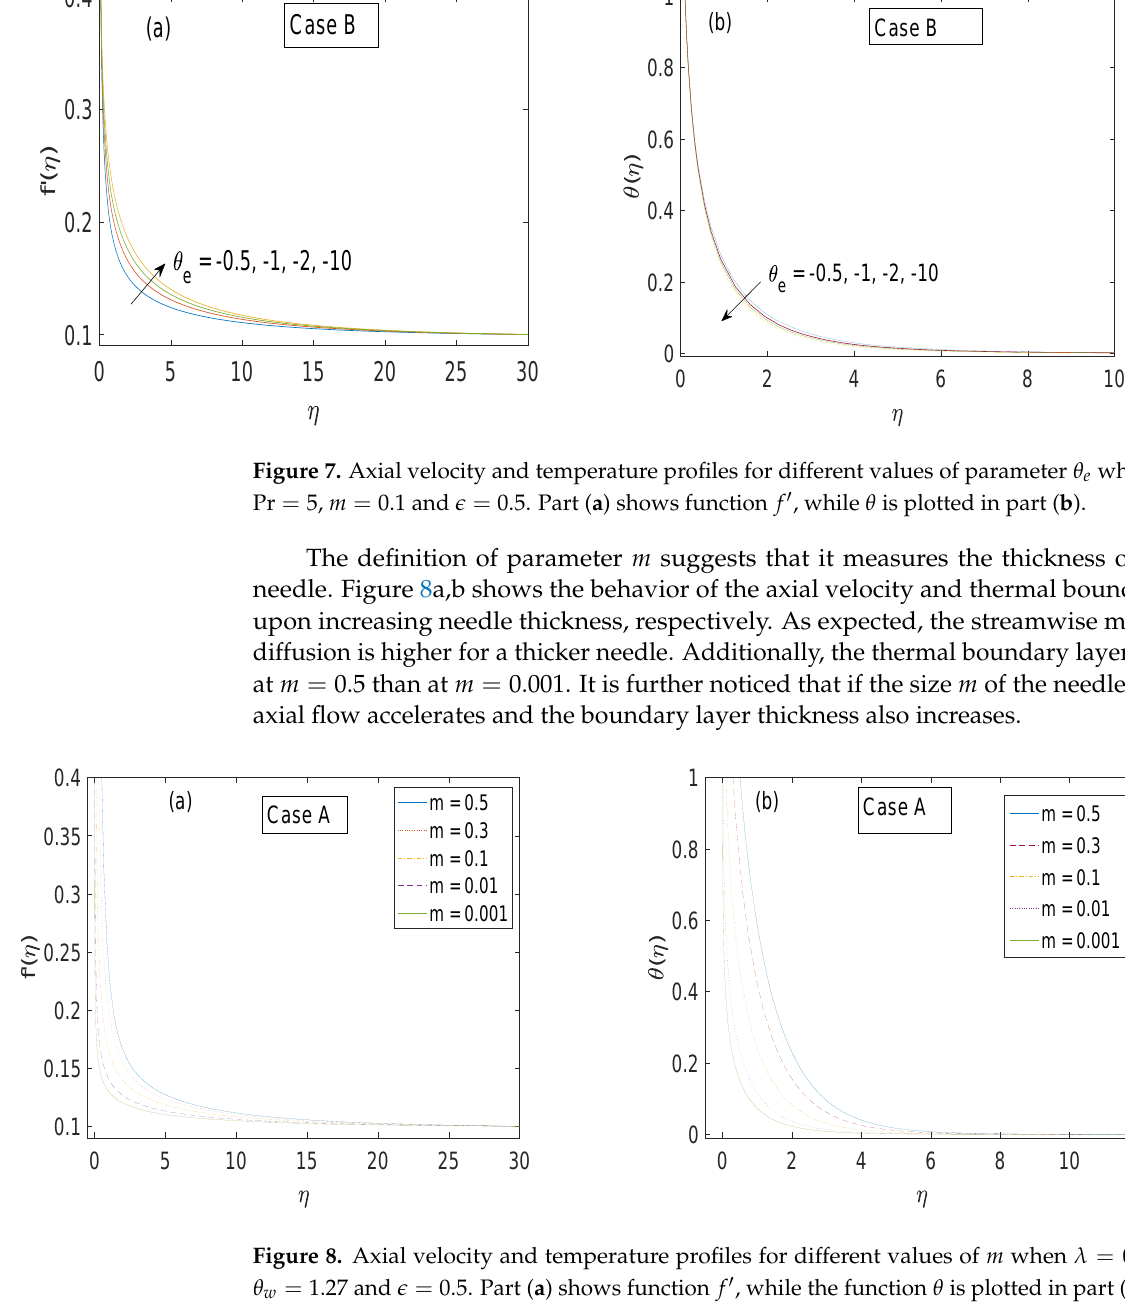
Figure 8. Axial velocity and temperature profiles for different values of m when λ = 0.8, Pr = 5, θ w = 1.27 and (cid:101) = 0.5. Part ( a ) shows function f (cid:48) , while the function θ is plotted in part ( b